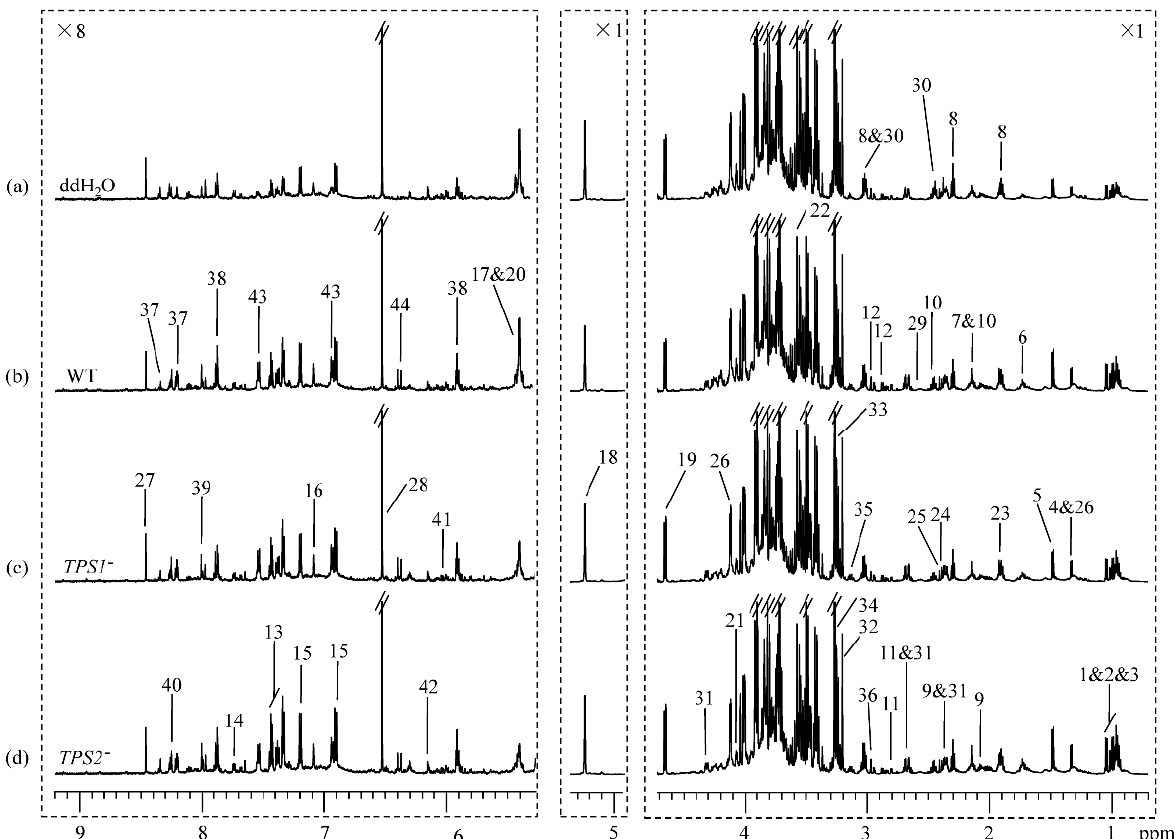
Figure 1. 1 H NMR spectra of extracts for resistant wheat Sumai 3 inoculated with ( a ) ddH 2 O, ( b ) Fg WT 5035, ( c ) Fg TPS1 − mutant, and ( d ) Fg TPS2 − mutant for 96 h. The region δ 5.31–9.21 was vertically